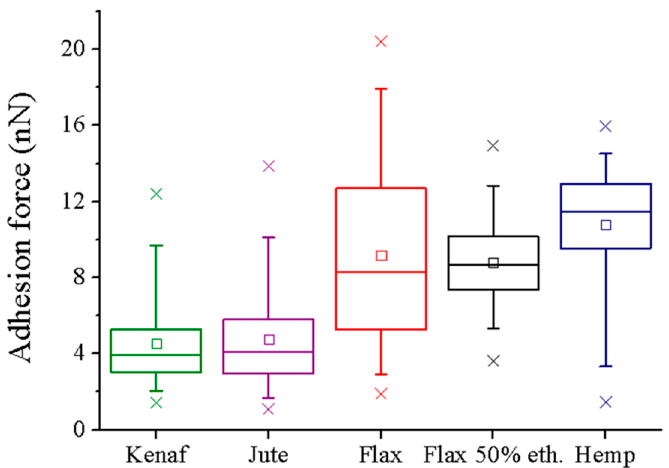
Figure 6. Statistical analysis of the rupture forces obtained between PBS functionalized tip and the longitudinal surface of plant fibers.